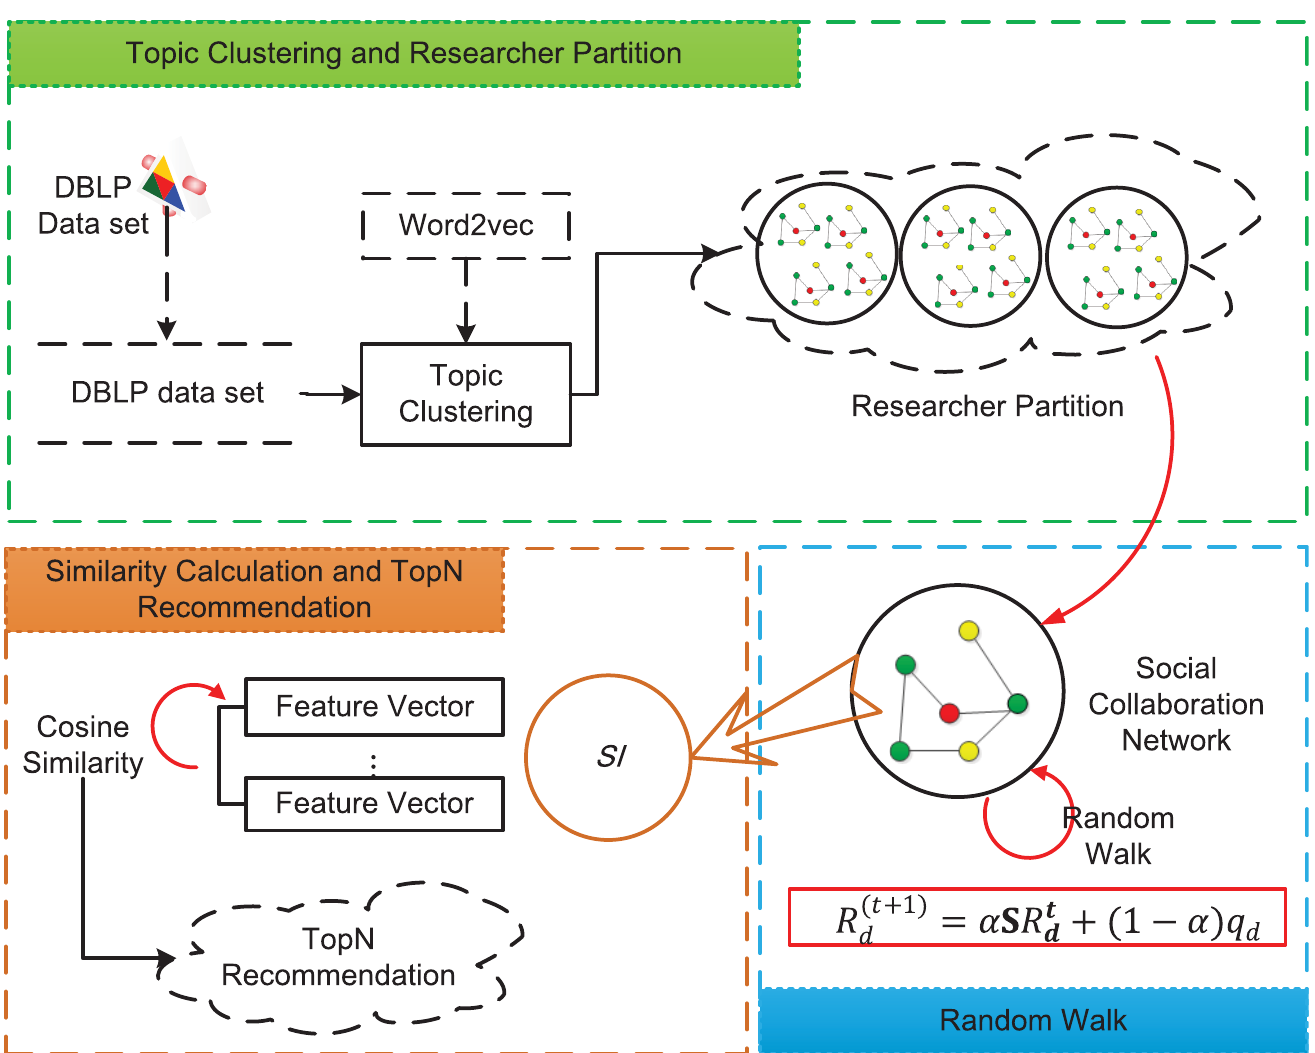
Fig 1. The architecture of CCRec. Depicts the three main components of CCRec: topic clustering and researcher partition, random walk, similarity calculation and top-N